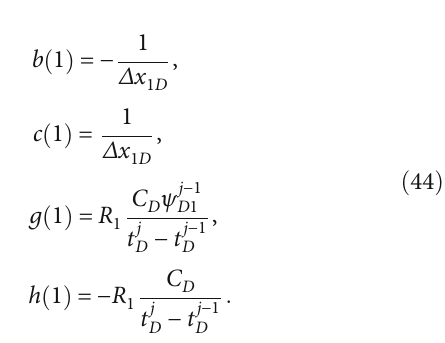
Figure 10: Well test curves of the pressure drawdown well test considering the hysteresis e ff ect.